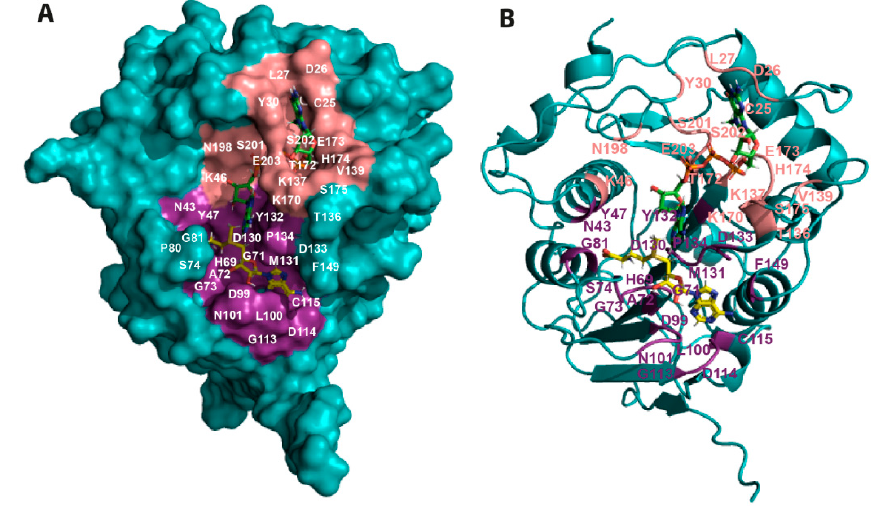
Figure 5. Mapping the residues implicated in SAM and RNA binding onto the SARS-CoV-2 NSP16 structure. ( A ) Surface representation of SARS-CoV-2 NSP16 (teal) (PDB ID 6WKS) showing the relative positions of the SAM (yellow) and RNA (green) binding regions. The RNA molecule binds to a groove proximal to the SAM binding pocket. The NSP16 residues located within 4 Å of SAM and RNA are shown in deep salmon and purple colour, respectively. ( B ) Ribbon representation of the ternary complex in the same orientation as (A).